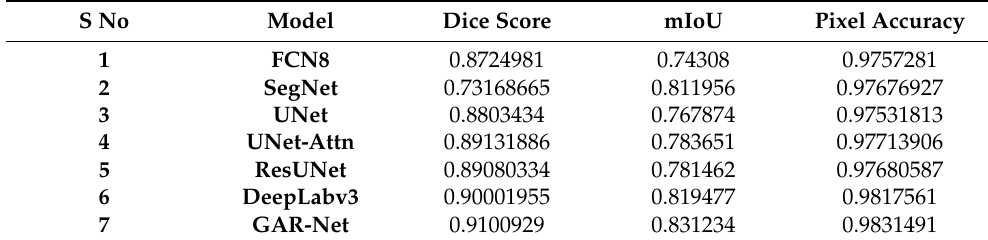
Table 1. The Results on the CVC-ClinicDB Dataset.